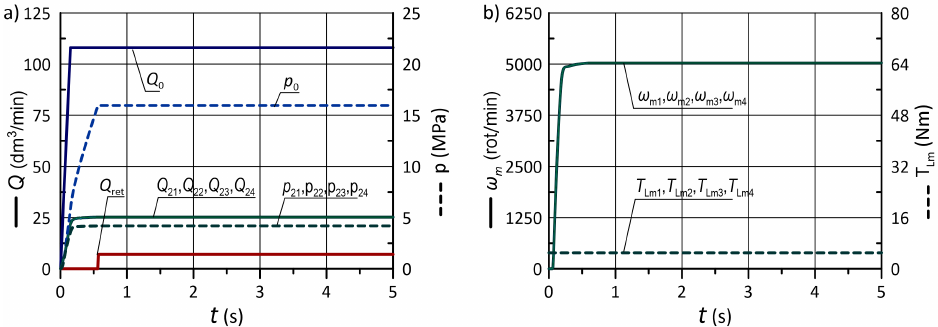
Figure 11. Results with constant load moment of low value T Lm = 5.0 N m: ( a ) flow rates and pressures; ( b ) rotational speed of hydraulic motors and load moments.